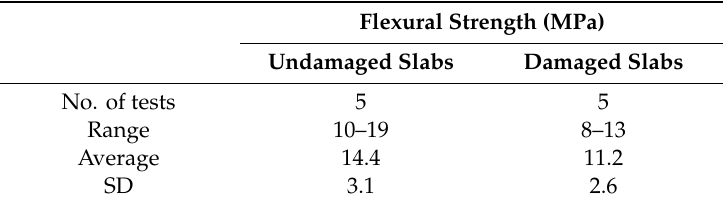
Table 8. Flexural strength average value and standard